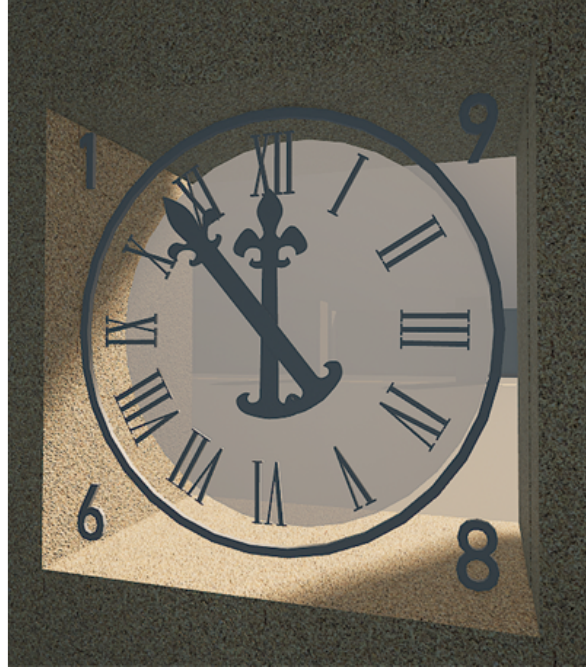
Figure 7 . Built-in clock on